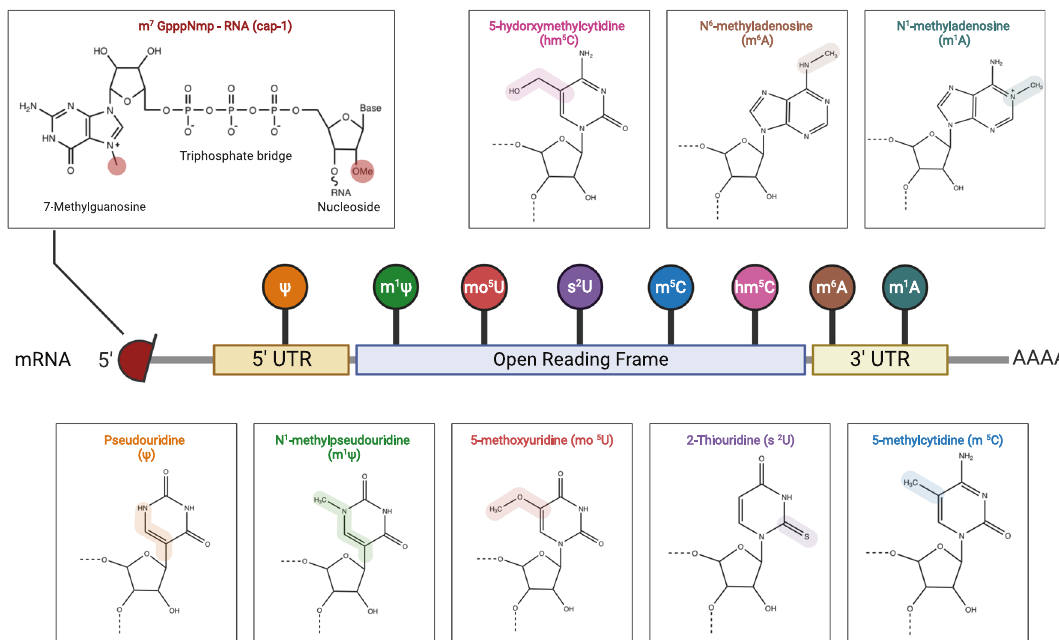
Fig. 4 Structure of mRNA and nucleotide modi fi cations. mRNA molecules are synthesized in vitro with a 5 ′ -cap 1 structure and chemically modi fi ed nucleotides as substitutes for natural nucleotides, which enhances stability and translation ef fi ciency of mRNA as well as reduces innate immune response. This fi gure is created with